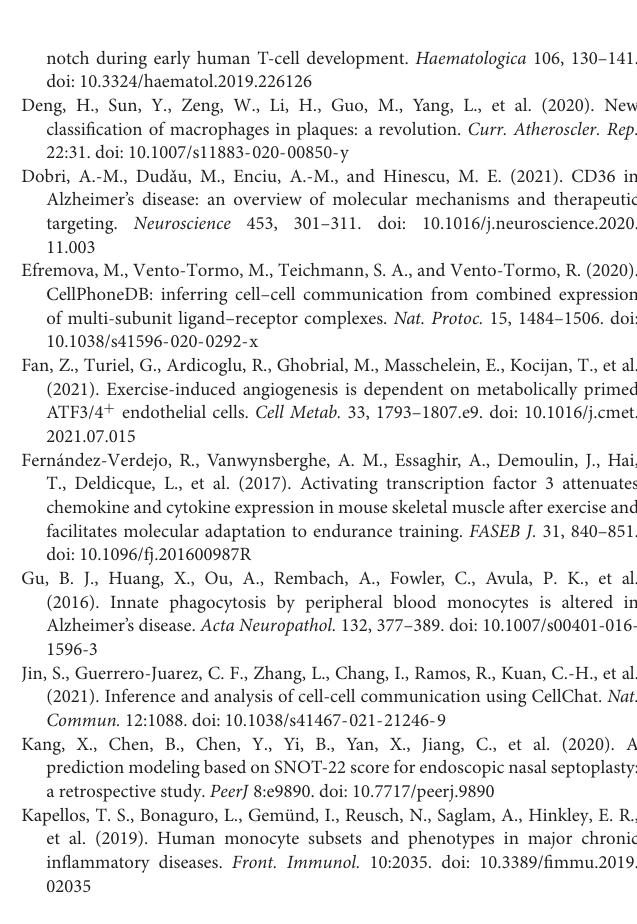
Supplementary Figure 1 | Quality control for the scRNA-seq data of GSE181279 dataset. (A) The plot on the left represents a scatter plot of the number of mitochondria in individual cells and number of RNAs detected. The plot in the middle represents a scatter plot of the number of signature genes in relation to the number of RNAs detected. The plot on the right represents a scatter plot of the number of erythrocyte proteins mixed in the sample in relation to number of RNAs detected; (B) Distribution of all clusters is represented with a UMAP plot, where different colors represent different samples; (C) Differences in signature RNA expression, the total number of RNAs detected, pMT, and pHB in different clinical samples. pMT: percent of mitochondrial counts; pHB: percent of hemoglobin RNA counts. Supplementary Figure 2 | Intersection and enrichment analysis of DEGs in CD14 + and CD16 + monocytes from Alzheimer’s Disease (AD) patients for the GSE51835 bulk RNA dataset. (A,B) Cellchat-based results demonstrating the association of specific cell populations with other cell populations on various cellular pathways, including the ANNEXIN signaling pathway (A), and RESISTIN signaling pathway (B); (C) Venn diagram showing results of intersection analysis of DEGs in CD14 + and CD16 + monocytes from AD patients for the GSE51835 bulk RNA dataset; (D) Differentially expressed genes co-expressed in CD14 + monocytes from AD patients after exercise; (E) Differentially expressed genes co-expressed in CD16 + monocytes from AD patients after exercise.